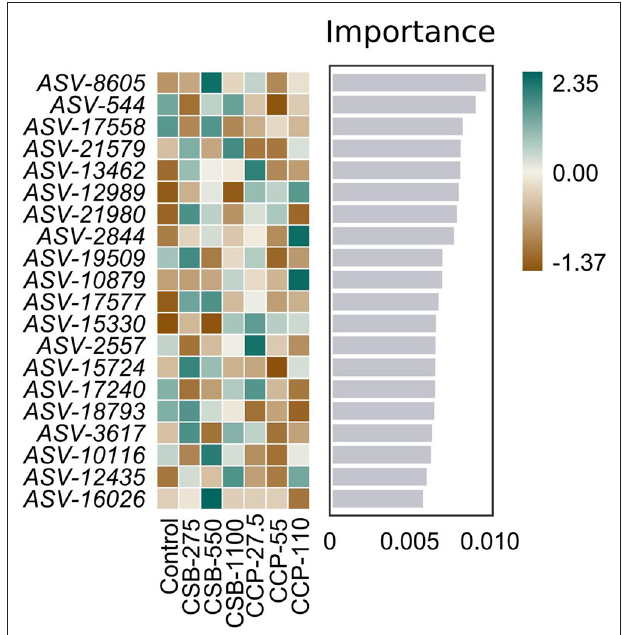
FIGURE 5 | Random forest distribution results. The darker the color, the higher or lower the flora abundance, so as to reflect the flora abundance difference of each